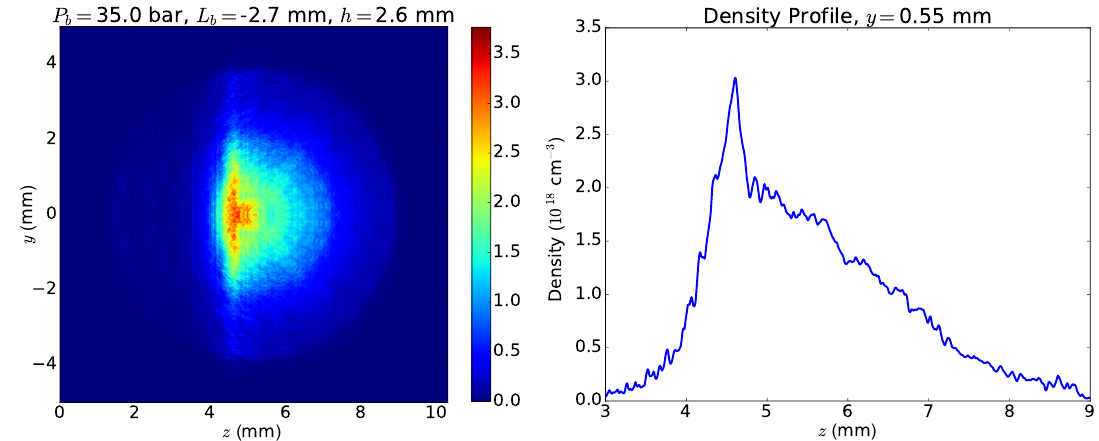
Figure 17. Left : ML-EM Reconstructed density distribution in a plane perpendicular to the gas flow at distance h = 2.6 mm from the nozzle, i.e., 1 mm from the blade. Right : Density profile along z direction for y = 0.55 mm.